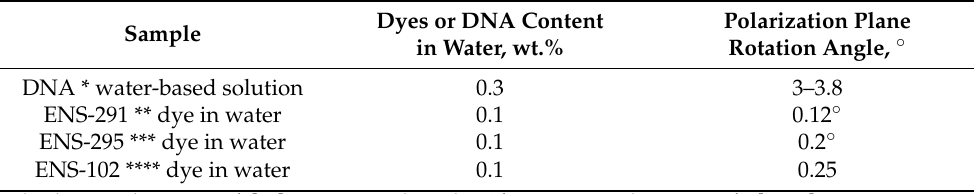
Table 2. Polarization plane rotation angle for some dyes and DNA.